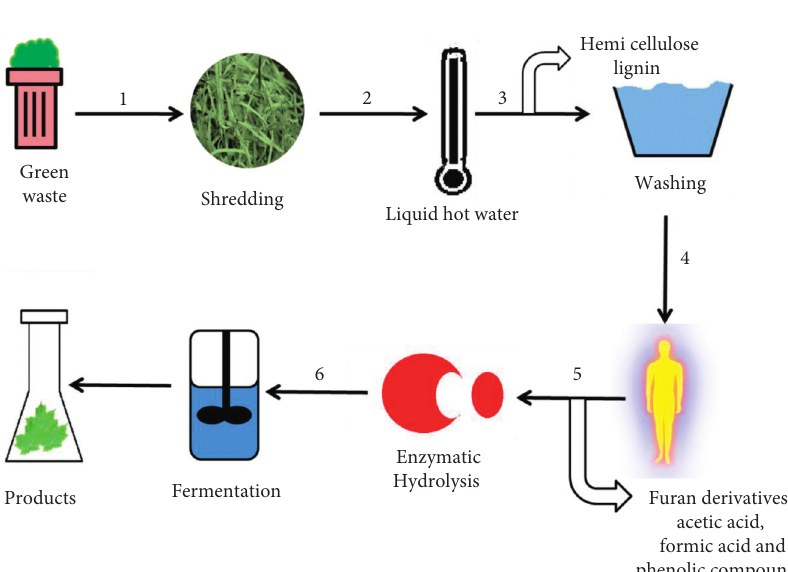
Figure 4: The pretreatment procedure for lignocellulosic biomass for fermentative utilization. (1) Shredding. (2) Use of high temperature and pressure to remove both lignin and hemicellulose. (3) Washing of the hydrolysate. (4) Detoxification. (5) Isolation of the mono- saccharides, the samples undergoing enzymatic hydrolysis. (6) Microbial fermentations [64] (Figure 4).